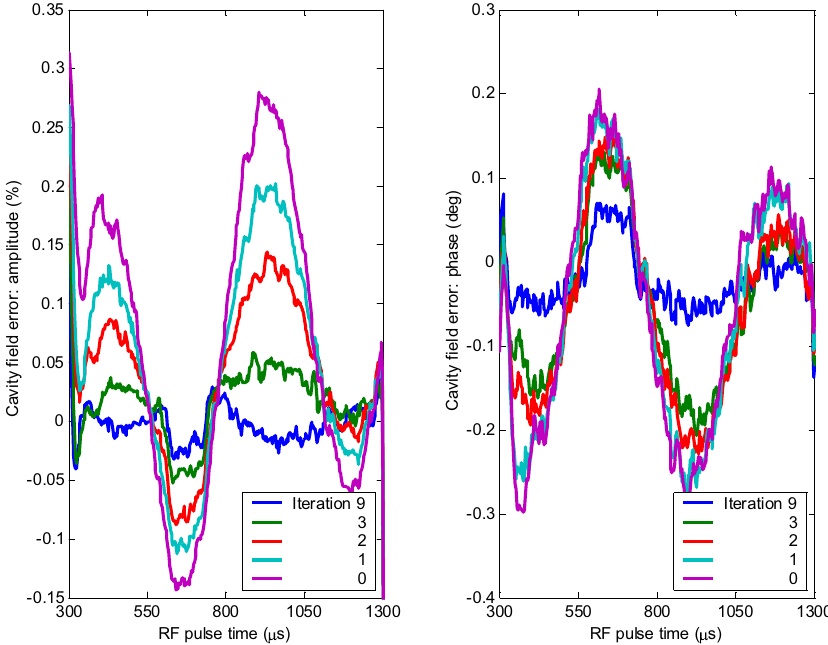
FIG. 12. (Color) The adaptive feed-forward compensation is also a very effective means for damping the mechanical mode. The pulse- to-pulse field error minimizing is a basic adaptive correction process with the feed forward compensation vector reiteratively modified by a sum of the proportion and integral of the field error vector, and each of the two terms in the sum is individually